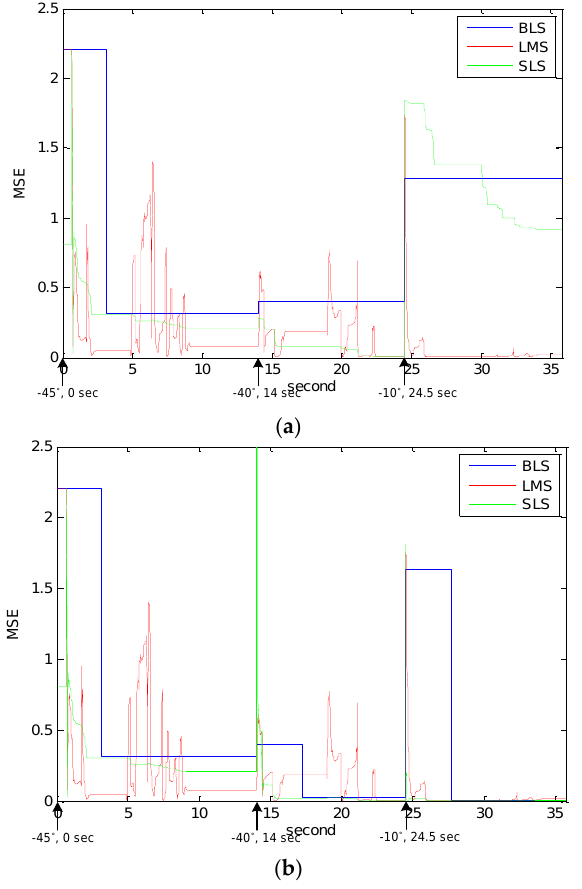
Figure 3. MSE as a function of time, ( a ) “no reset” case, ( b ) “reset” case. Table 1. Averaged MSEs.